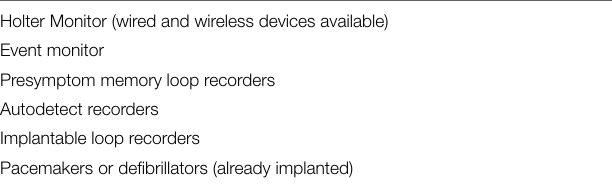
TABLE 1 | Types of cardiac monitoring devices.